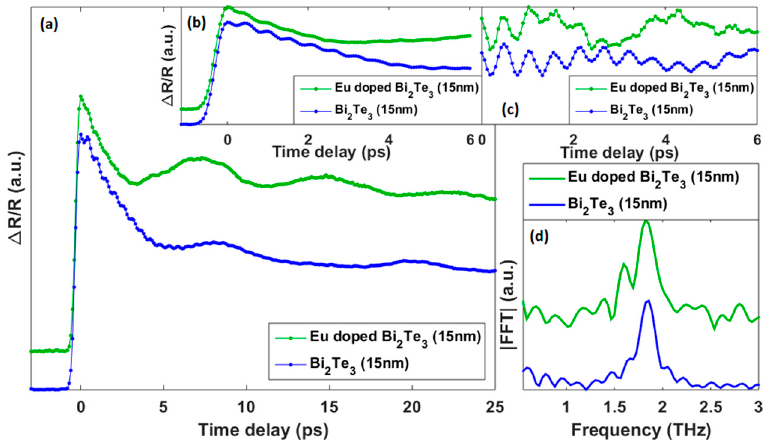
Figure 7. ( a ) Transient optical reflectivity measured for doped and undoped Bi 2 Te 3 film. ( b ) Zoom on the first 6 ps time windows. ( c ) Coherent A1g optical phonon signal. ( d ) Fast Fourier Transform of the signal shown in (c).